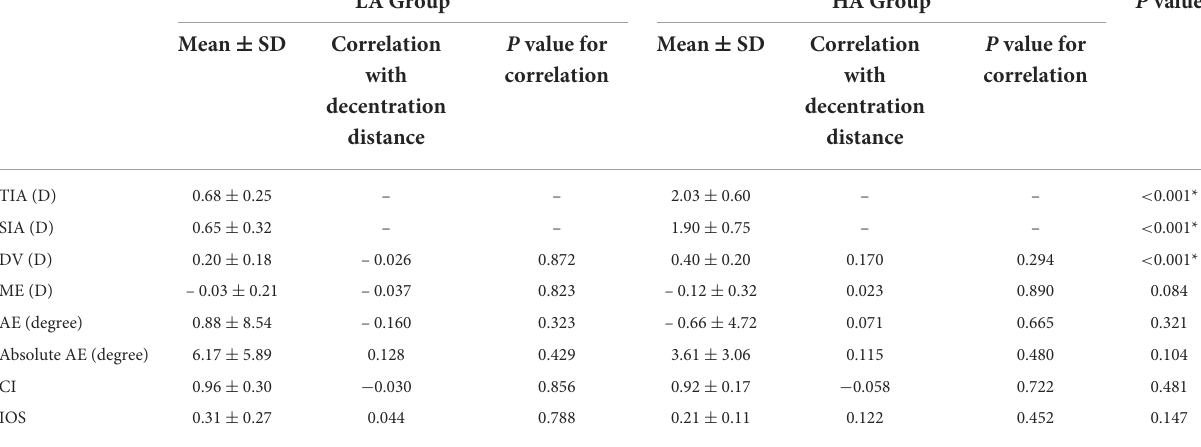
TABLE 2 Vector analysis results of astigmatism correction at 6 months after